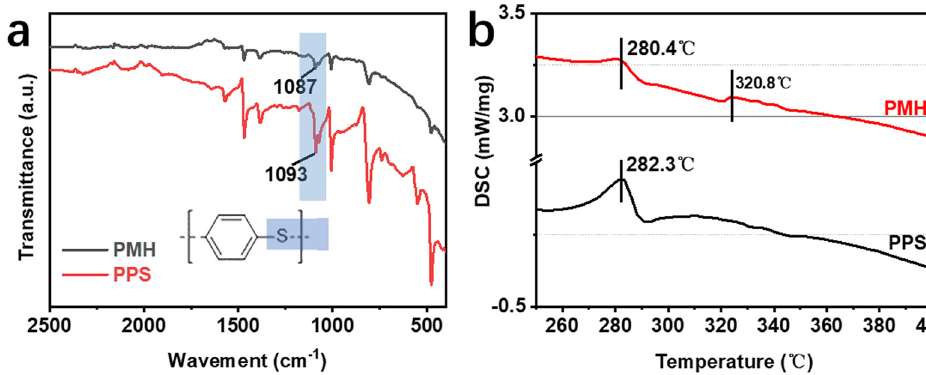
Figure 6: Structural analysis of PMH: ( a ) the ATR spectrum and ( b ) the DSC curves of PPA and PMH.